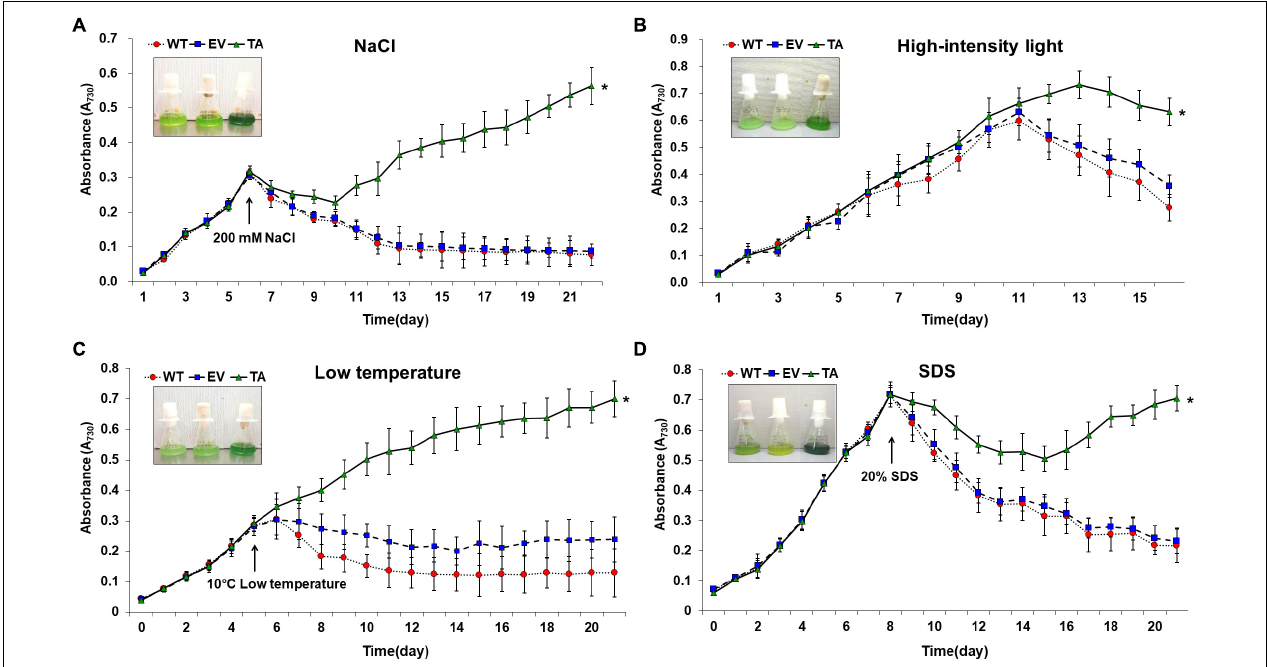
FIGURE 7 | Growth profiles of WT, EV, and TA in the presence of oxidative stressors, including (A) 200 mM NaCl after incubation for 6 days, (B) 250 µ E high-intensity light during continuous incubation, (C) low temperature (10 ◦ C) after incubation for 5 days, and (D) 20% SDS after incubation for 8 days. Photographs were taken approximately 3 days after stress treatments at which point the sensitive phenotype appeared. Error bars indicate ± SD of biologically least three independent experiments. Asterisks indicate significant differences between treatments as estimated by Student’s t -test ( P < 0.05). WT, WT S. elongatus PCC 7942; EV, empty vector S. elongatus PCC 7942; TA, TA S. elongatus PCC